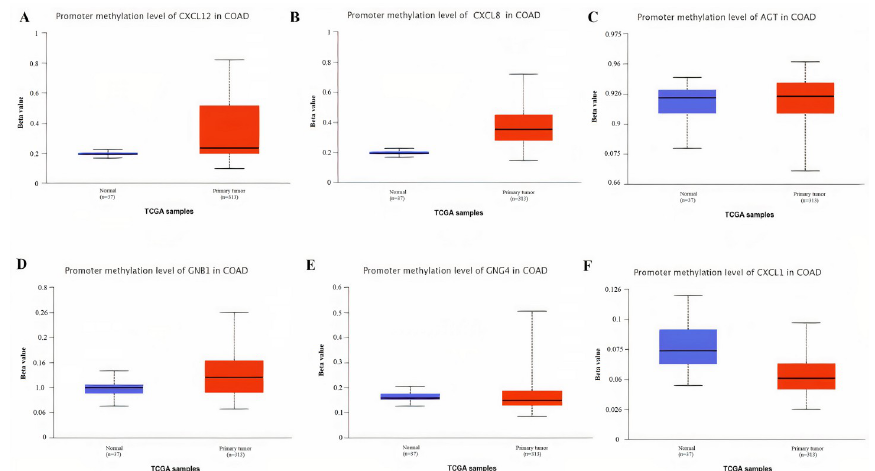
Fig 11. Box plot showing real hub genes promoter methylation levels in normal individuals and COAD patients via UALCAN database. The box plot shows the promoter methylation levels of: ( A ) CXCL12 (B) CXCL8 (C) AGT (D) GNB1 (E) GNG4 (F) CXCL1 in normal individuals and COAD patients. A p-value of < 0.05 was considered significant.